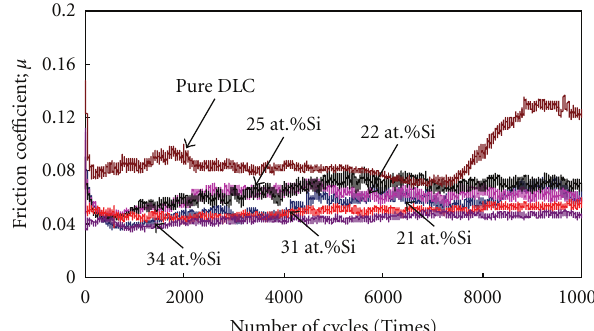
Figure 5: Changes in friction coe ffi cients of DLC-SiO films before annealing.